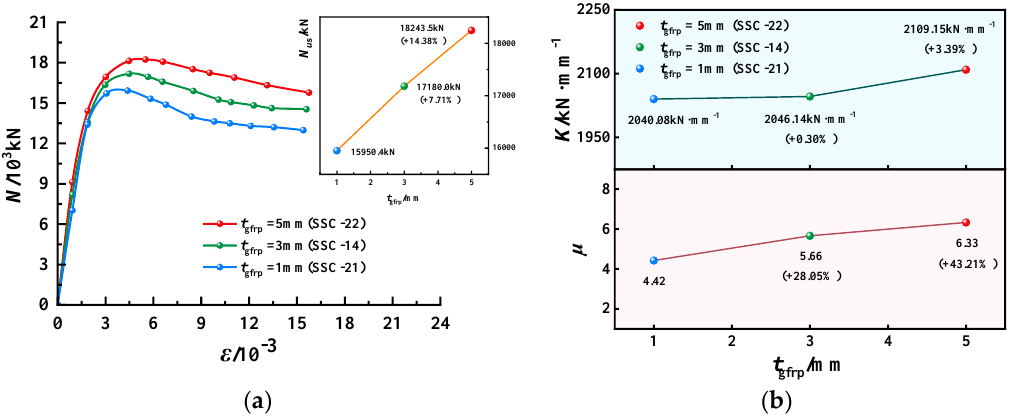
Figure 12. N - ε curves, K and µ of EGCSSCs with different t gfrp : ( a ) N - ε curves of specimens with cross-section height of 1000 mm. ( b ) K and µ of specimens with cross-section height of 1000 mm.